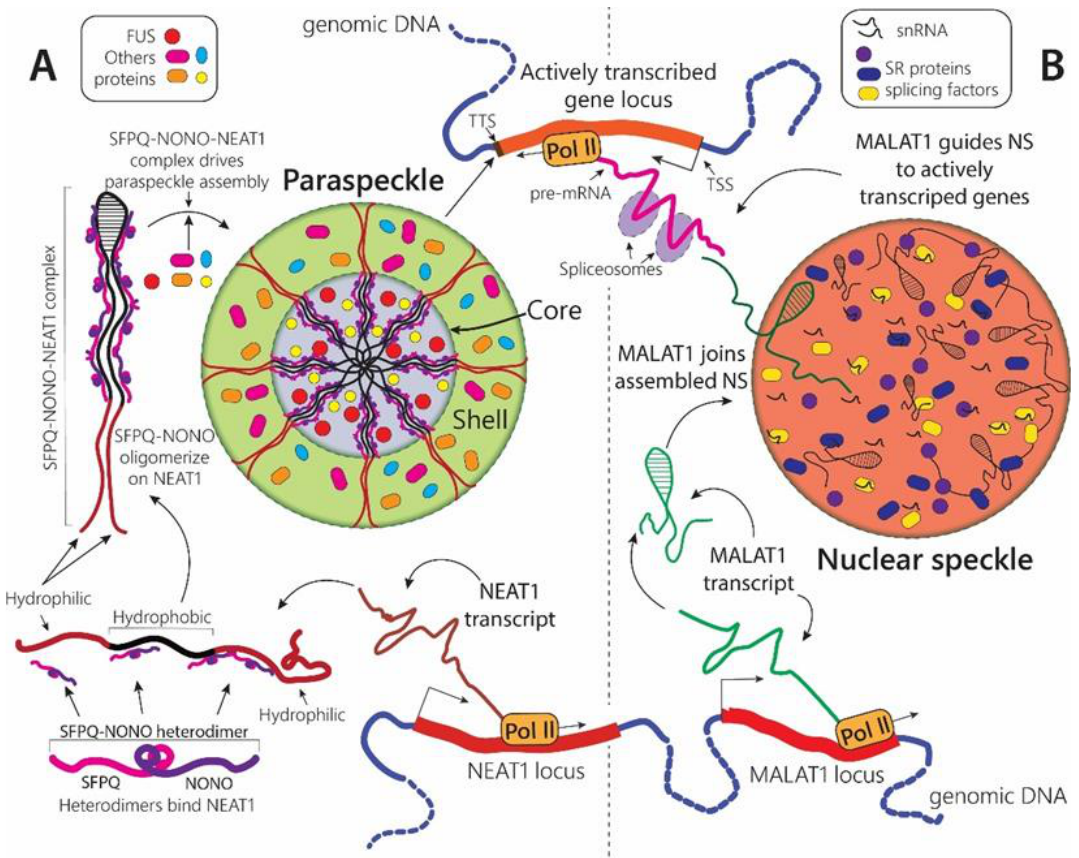
Figure 3. Assembly and cooperation of nuclear speckles and paraspeckles. ( A ) Paraspeckles assemble at sites of NEAT1 lncRNA expression. Nascent NEAT1 transcripts sequester SFPQ-NONO het-